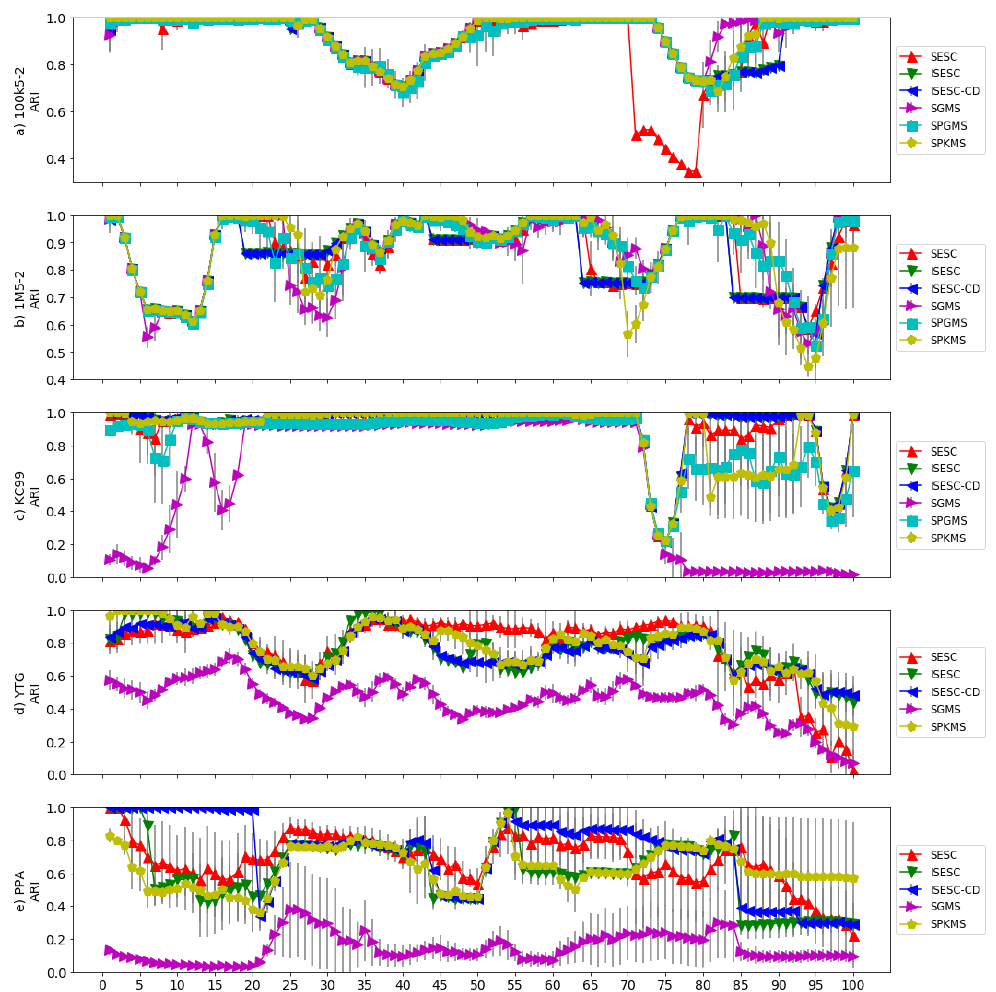
Figure 7. ARI comparison among the presented algorithms over the five most relevant data set results. The markers represent the ARI score of each algorithm over each data set. The vertical grey bars represent the standard